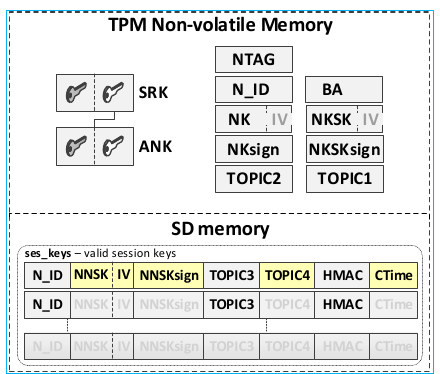
Figure 21. An example of the data stored on each N-type node after the procedure for generating session keys (the first entry in the ses_keys file is complete → the keys described there are known to N1 and N2).